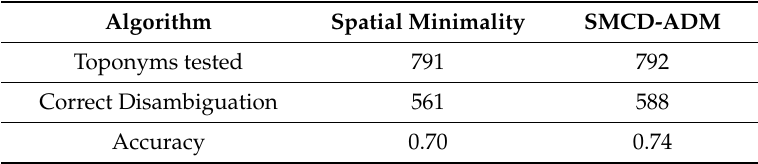
Table 11. Toponym resolution performance (accuracy) (step 2).